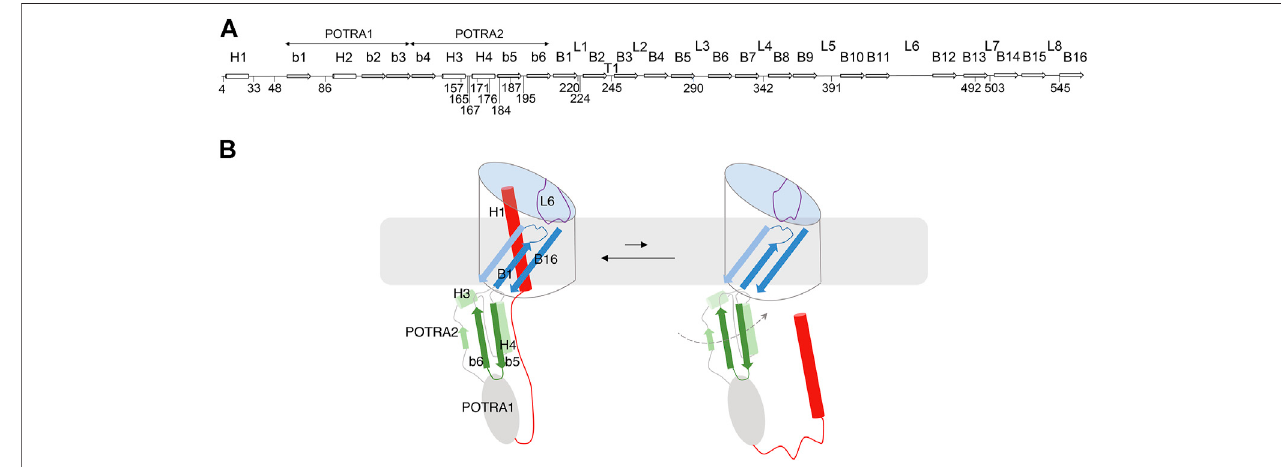
FIGURE 1 | FhaC: Secondary structure and intrinsic dynamics. (A) Linear representation of the secondary structure elements of FhaC, with residues used in this work. L1 to L8 represent the extracellular loops, b1 to b6 the β strands of the POTRA domains, H1 to H4 the α helices, and B1 to B16 the β -barrel strands. T1 is the fi rst periplasmic turn. (B) Schematic representation of known FhaC motions linked to its activity. Speci fi c structural elements are colored as follows: H1 and the linker in red, the POTRA2 domain in shades of green, L6 in purple, and β barrel strands B1, B2 and B16 in shades of blue. In its resting conformation (left), FhaC is closed, with H1 crossing the β barrel. The linker is positioned along the H4 helix of the POTRA2 domain (Maier et al., 2015), thus obstructing a major substrate binding site (Delattre et al., 2011). L6 is folded inside the barrel with a conserved interaction between its tip and the barrel wall. This conformation is in equilibrium with an open form (right), in which H1 has vacated the pore and the substrate binding site is available (Guérin et al., 2014). We have obtained evidence that L6 also moves away from its resting position in the β barrel and that the POTRA2 domain undergoes so far unde fi ned motions (represented as a dashed line) (Guérin et al., 2015).